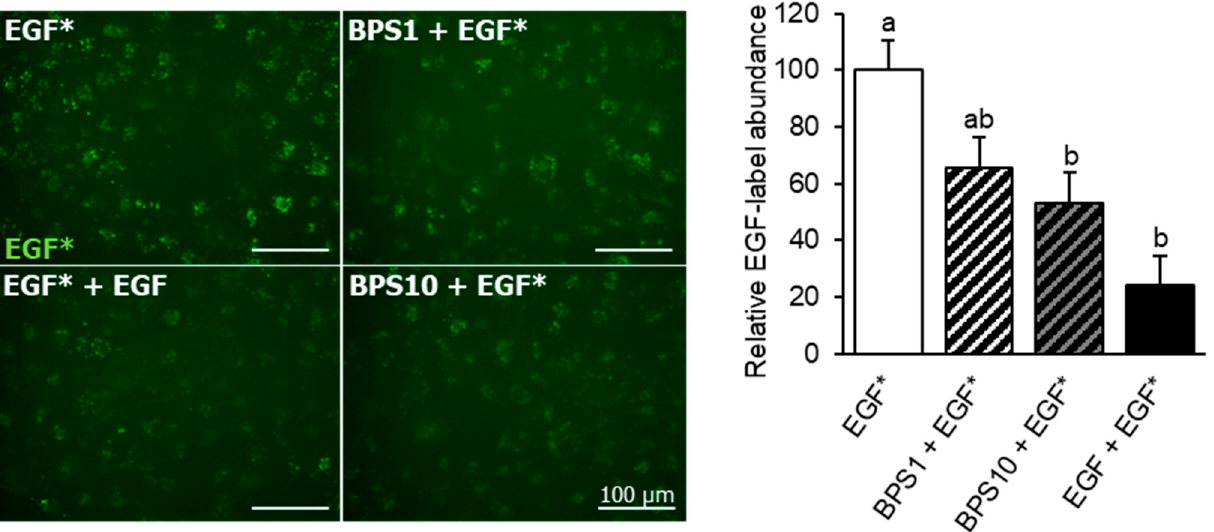
Figure 2. Effect of BPS on EGF internalization in HTR-8/SVneo cells. Representative images ( left ) of EGF in HTR-8/SVneo cells, and quantification (mean ± SEM) ( right ) following exposure to: (1) EGF* (100 ng/mL Alexa Fluor 647-labelled EGF), (2) BPS1 + EGF* (1 µ g/mL BPS + 100 ng/mL EGF*), (3) BPS10 + EGF* (10 µ g/mL BPS + 100 ng/mL EGF*) and (4) EGF + EGF* (100 ng/mL non-labelled EGF + 100 ng/mL EGF*). Images were taken 1 h after a 5 min exposure. Results were normalized by the total number of cells, and expressed as relative percentage of the EGF* group. A generalized linear model was used to statistically compare treatments. Different letters denote statistical differences among treatment groups at p < 0.05 ( n = 4 technical replicates/group).